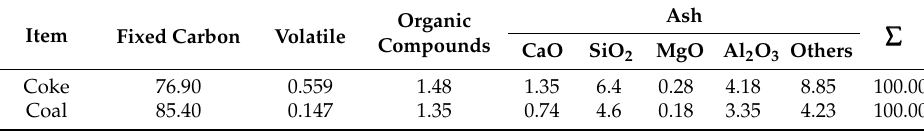
Table 4. Industrial analysis of coke breeze and chemical compositions of the ash (wt %).